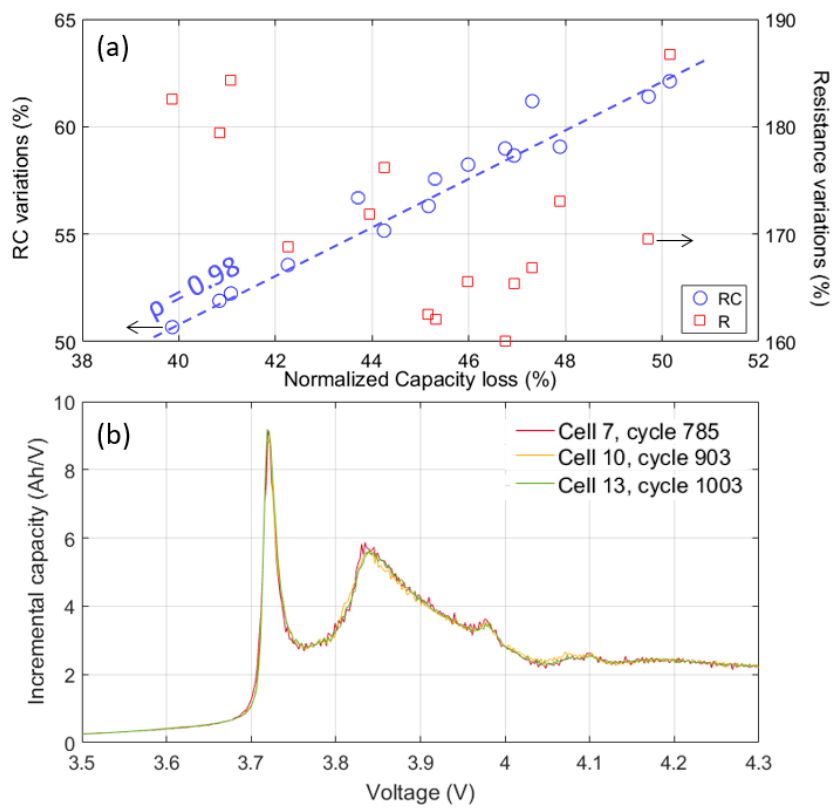
Figure 7. ( a ) Spread of rate capability and resistance after 1000 cycles; ( b ) Comparison of three disparate cells at 24% capacity loss.